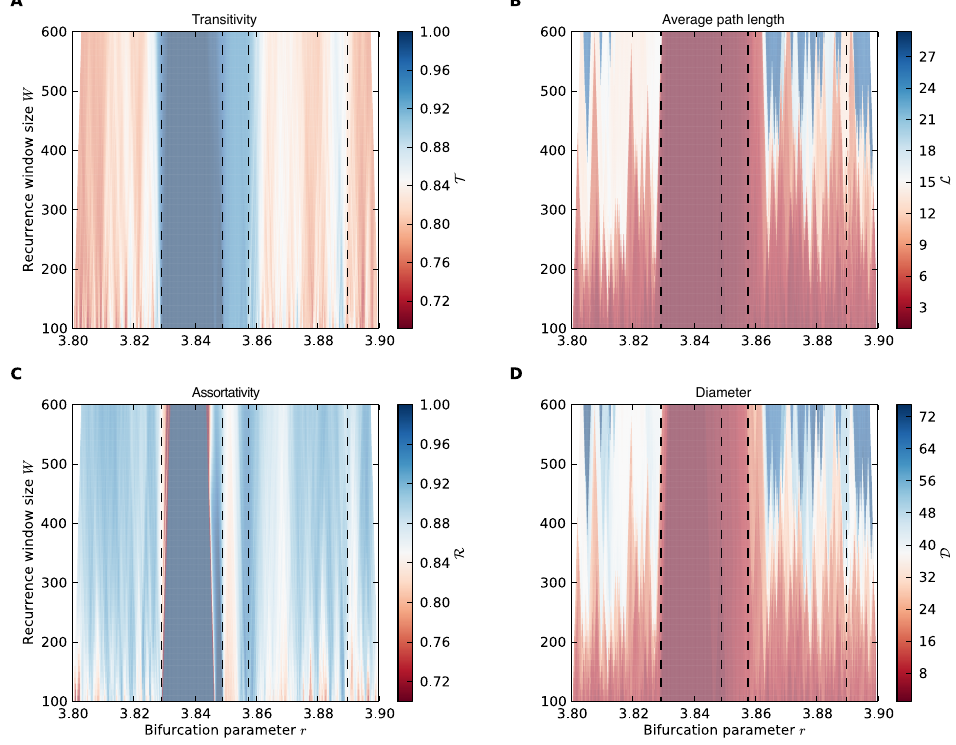
Fig. 7. (A) Transitivity T , (B) average path length L , (C) assortativity R , and (D) diameter D for varying recurrence window size W for the logistic map (Eq. 18) with drifting bifurcation parameter r (see text) and initial condition x 1 = 0 . 7. W was varied linearly in the interval [100 , 600] , the recurrence window step size was fixed to ∆ W =10 time steps. No embedding was used and the threshold set to ε =0 . 05 σ (Marwan et al., 2009), where σ denotes the standard deviation of the time series segment within the recurrence window. Vertical dashed lines indicate the critial values of r discussed in the main text.